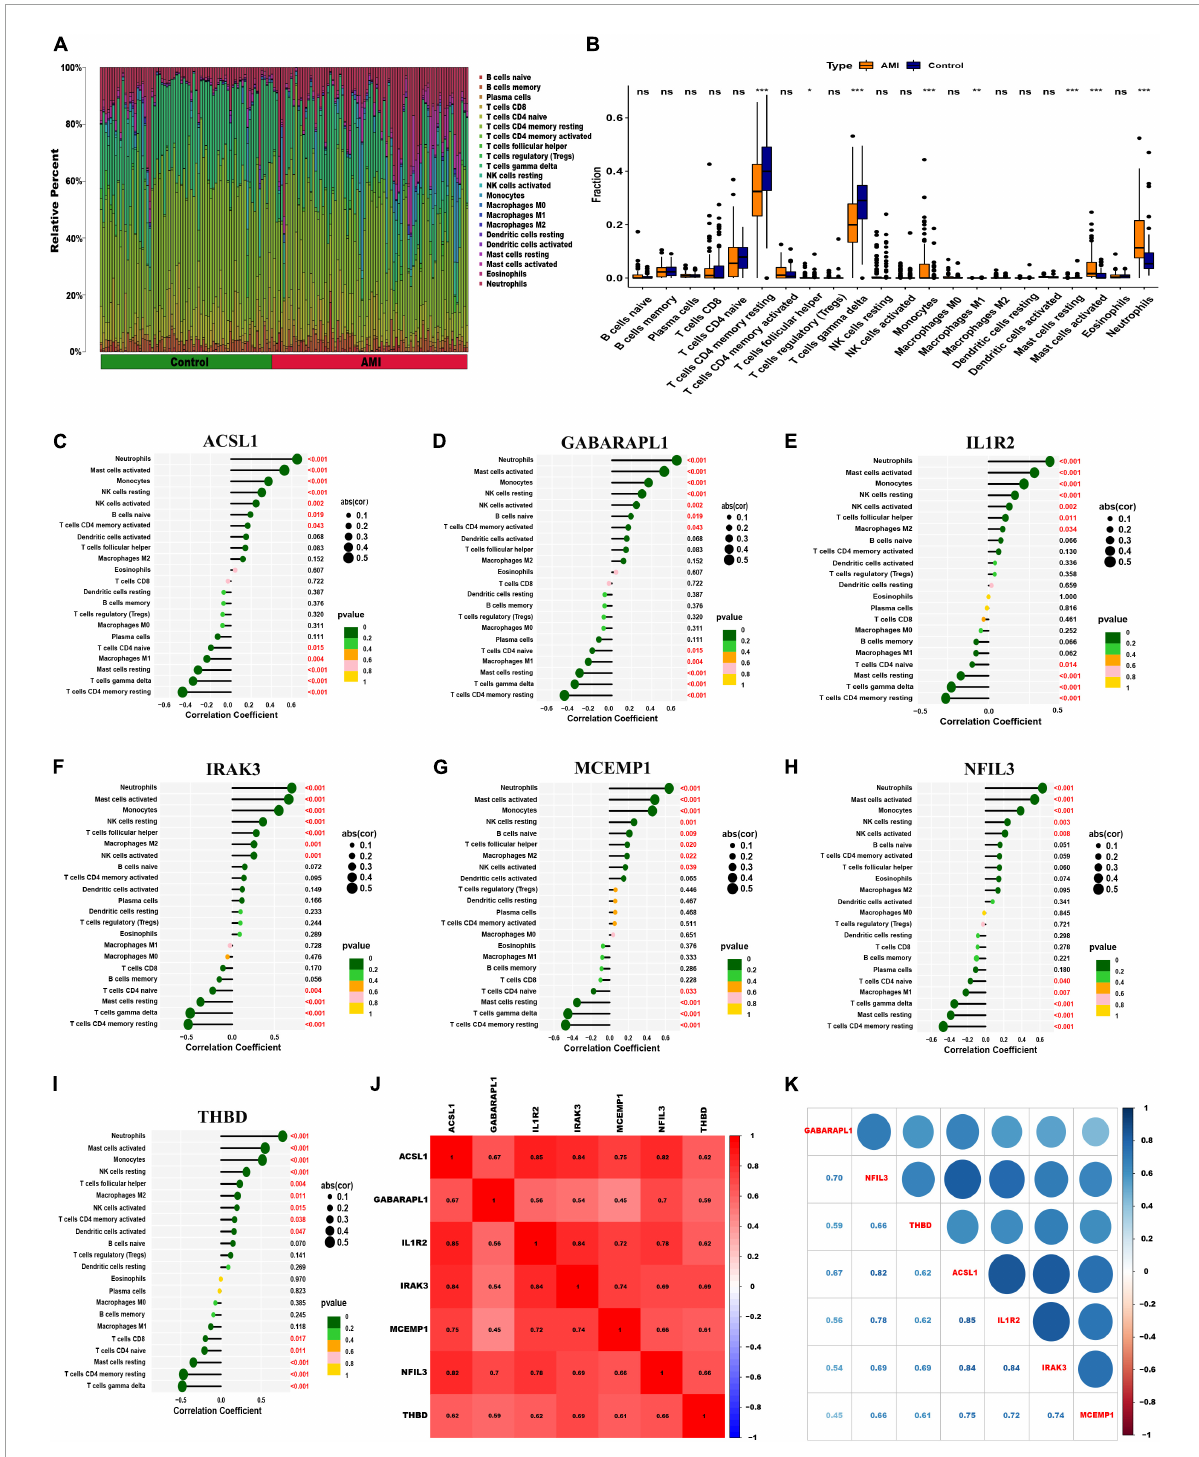
FIGURE9 Visualization of immune cell infiltration. (A) The relative proportions of 22 immune cells types between control samples and AMI samples. Panel (B) representative boxplot shows the differences of infiltrated immune cells between control samples and AMI samples. Statistic tests: Wilcoxon rank-sum test. ( P < 0.05*; P < 0.01**; P < 0.001***; ns, no significance). (C–I) Correlation between immune cells and optimal feature genes ACSL1 (C) , GABARAPL1 (D) , IL1R2 (E) , IRAK3 (F) , MCEMP1 (G) , NFIL3 (H) , and THBD (I) ; the larger the dots, the stronger the correlation. The color of the dots represents the P- value; the greener the color, the lower the P- value. (J,K) Correlation analysis of seven optimal feature genes in AMI